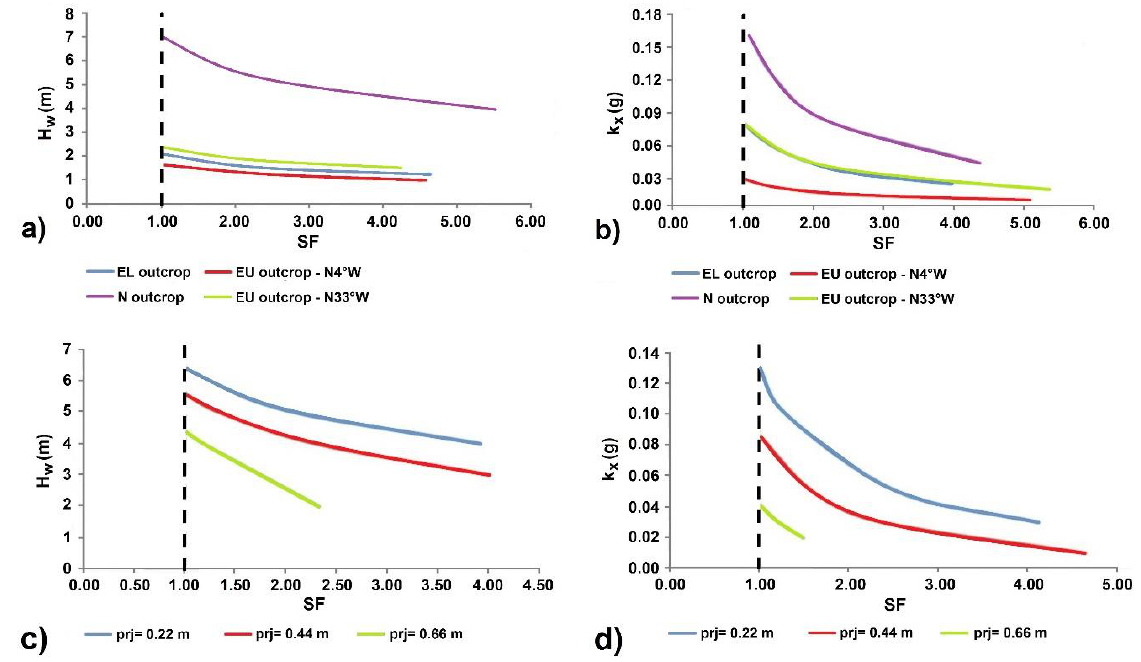
Figure 11. SF vs. H w ( a ) and k x ( b ) from a sensitivity analysis performed for the considered sectors of the slope. SF vs. H w ( c ) and k x ( d ) from a sensitivity analysis performed, in the case of projection, for the north sector of the slope.